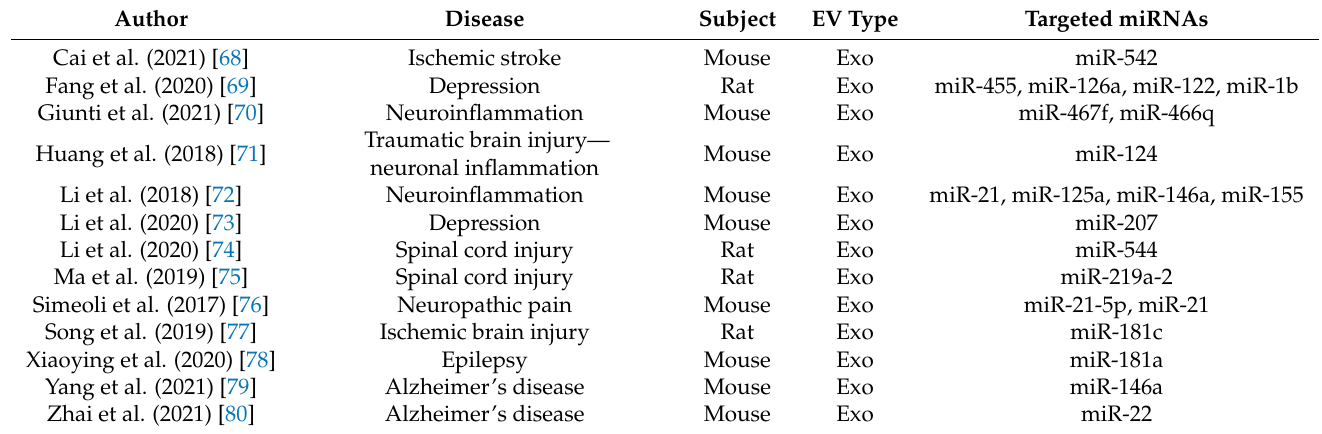
Table 3. Extracellular miRNAs in neurological